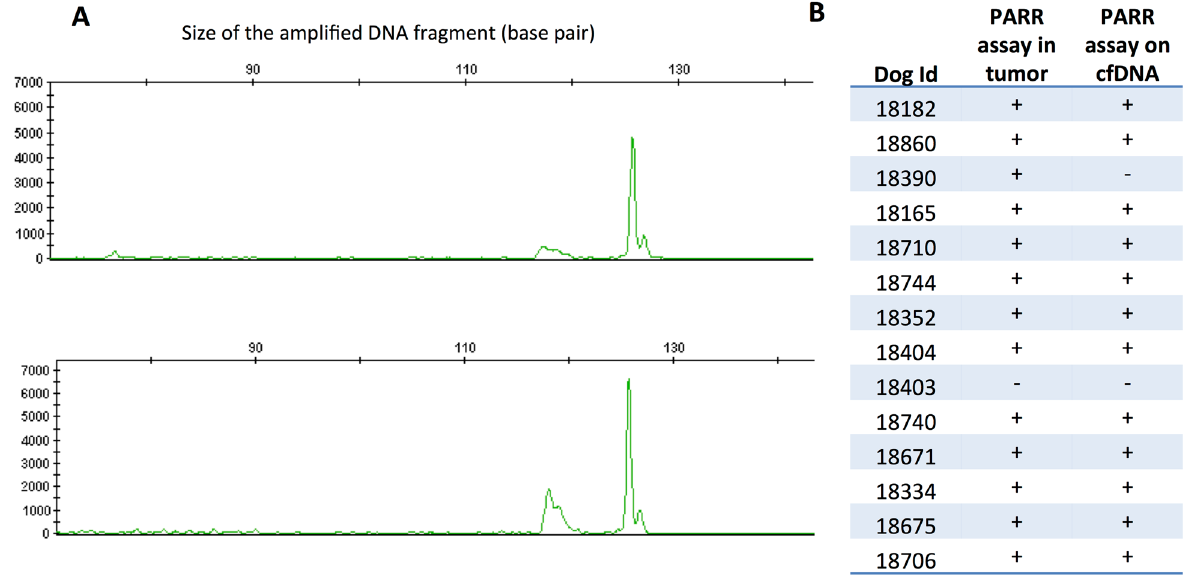
Figure 3. ( A ) Results of a PARR genotyping on the DNA extracted from a tumor sample (above) and plasma (below) from a dog with high-grade multicentric lymphoma (Id 18175) (drawing produced by GeneMapper Software 4.1: https ://www.therm ofish er.com/ order/catalog/product/4366925). The same clonal antigen receptor rearrangement (IgH major) was found with a high intensity in the tumor and the plasma. ( B ) Results of the PARR assay on canine lymphoma. The results on DNA extracted from the tumor and DNA extracted from plasma are shown. PARR was positive (clonal band) in the tumor and cfDNA for 12/13